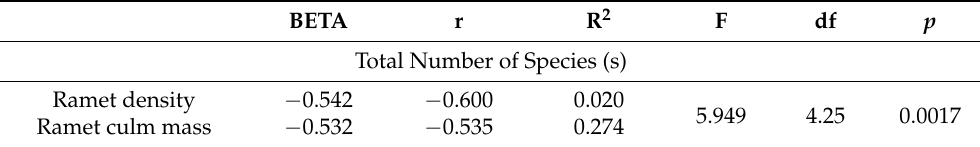
Table 2. Results of multiple regression analysis (stepwise progressive method) of Calamagrostis epigejos biometric parameters and the total number of species. The analyses were conducted for standardized and ln variables.